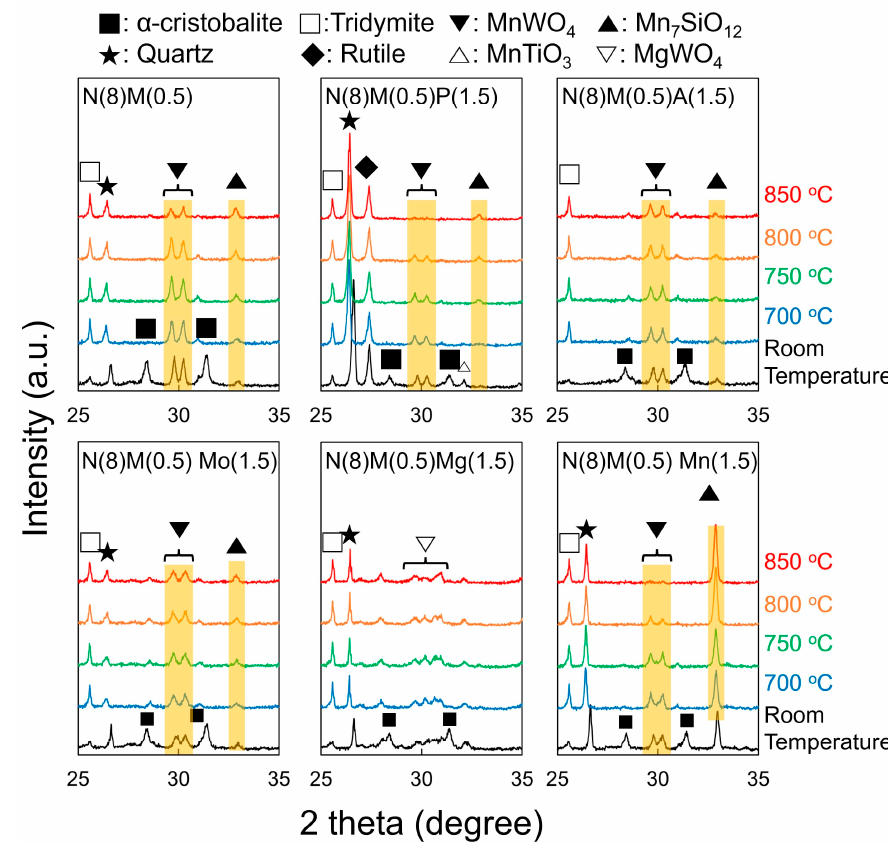
Figure 4. High temperature powder XRD results of spent catalysts.